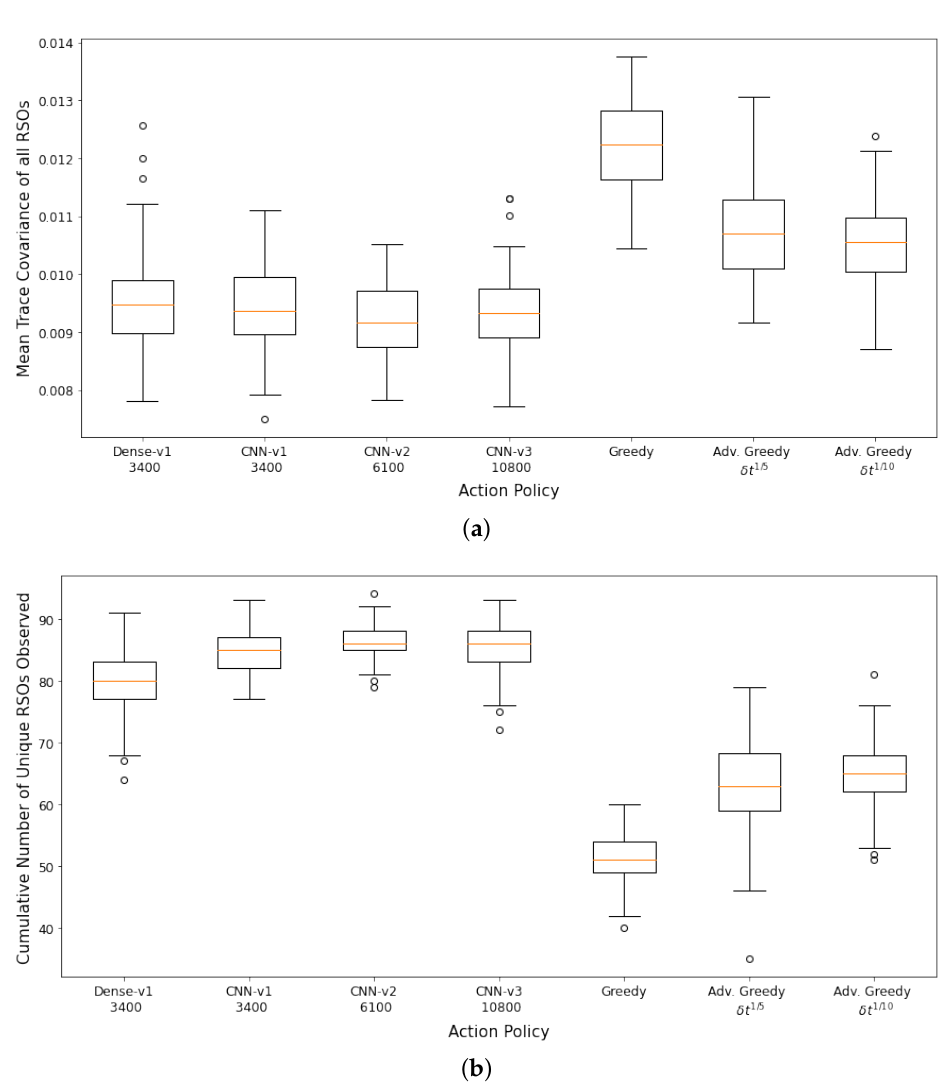
Figure 8. Aggregate performance of the DRL agents with 100 randomly initialized GEO RSOs, evaluated over 100 seeded rollouts of 90 min each. ( a ) Distribution of the final mean trace covariance at the end of the observation window (lower is better); ( b ) Distribution of the cumulative number of unique RSOs observed at the end of the observation window (higher is better). Note: CNN-v1 3400 represents a CNN-v1 DRL agent trained for 3400 training